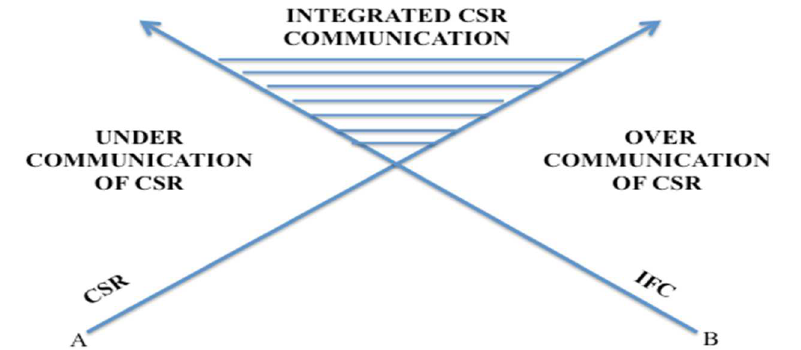
Figure 5: CSR Communication